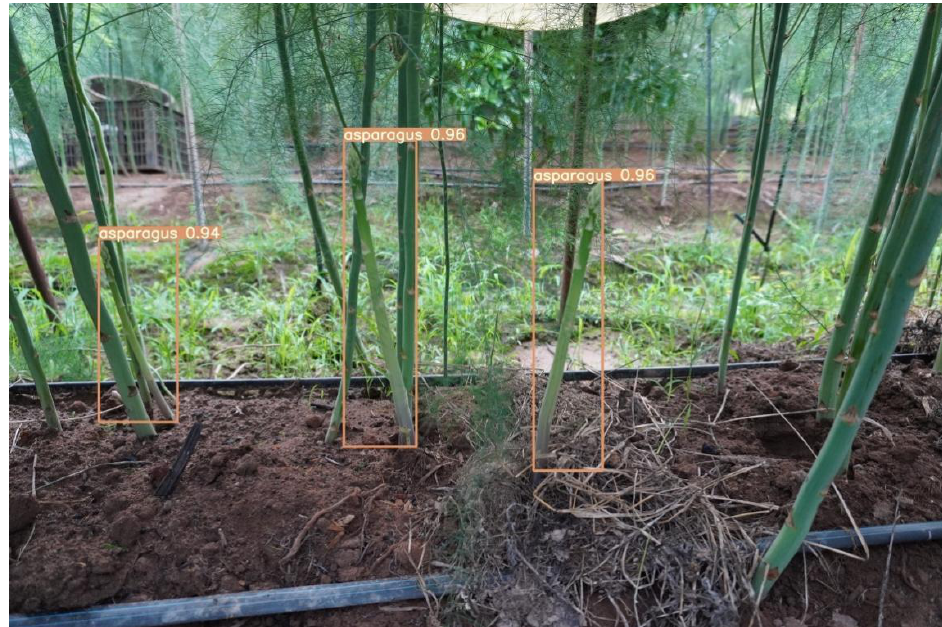
Figure 13. Detection effect.